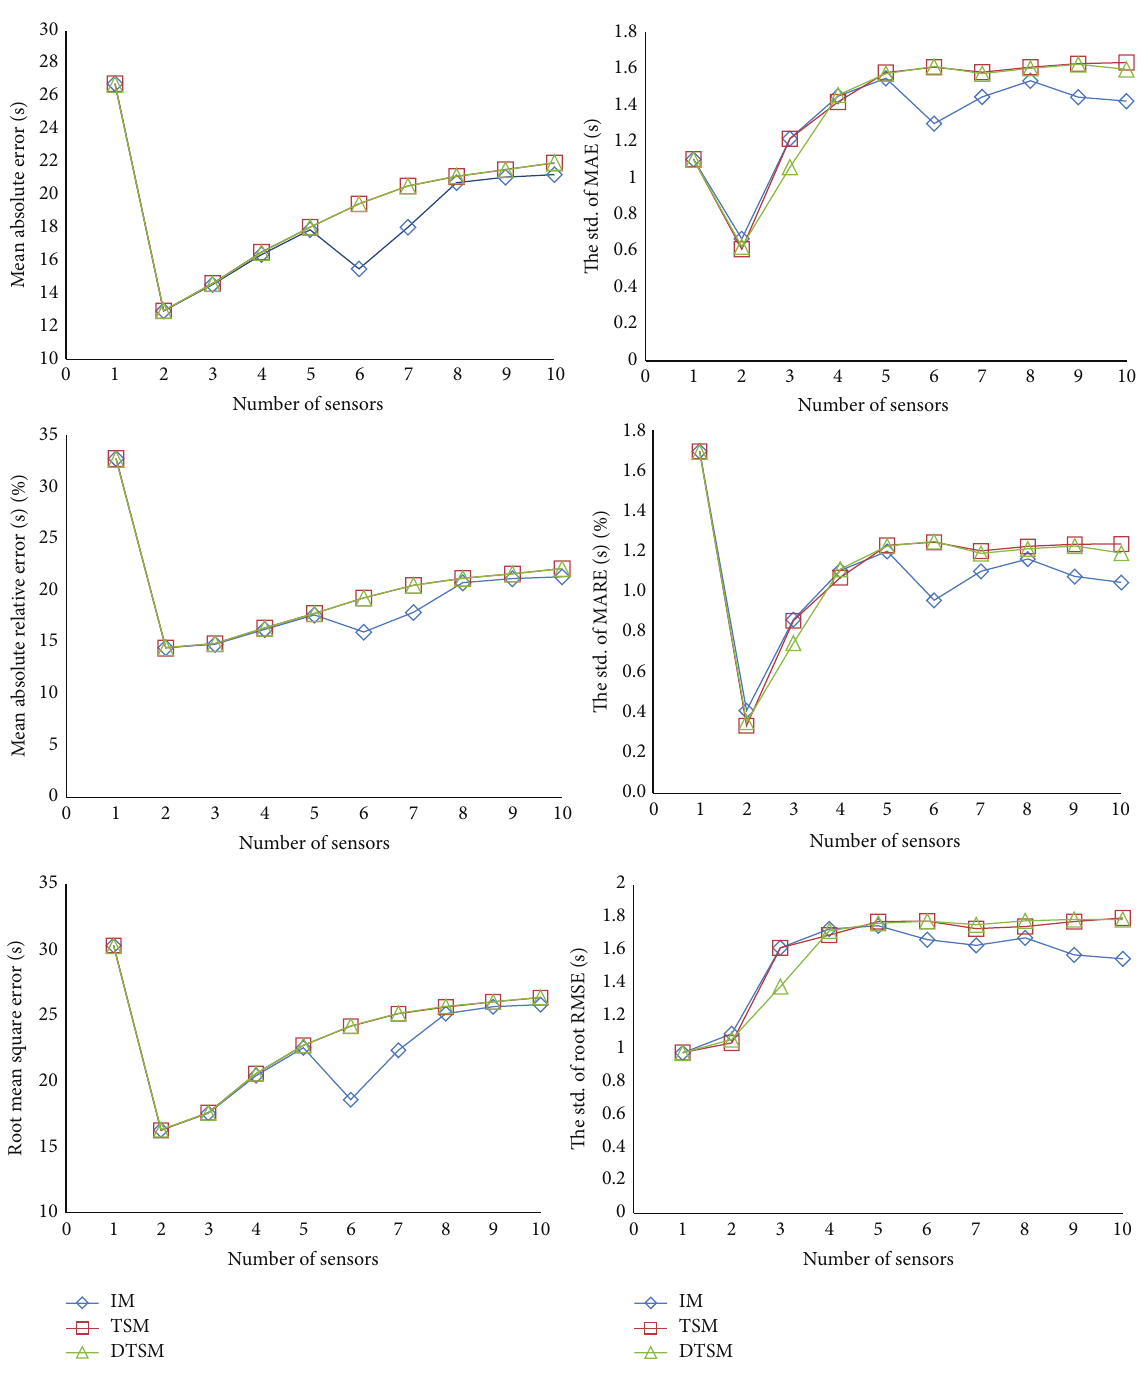
Figure 2: Errors and their standard deviations versus number of